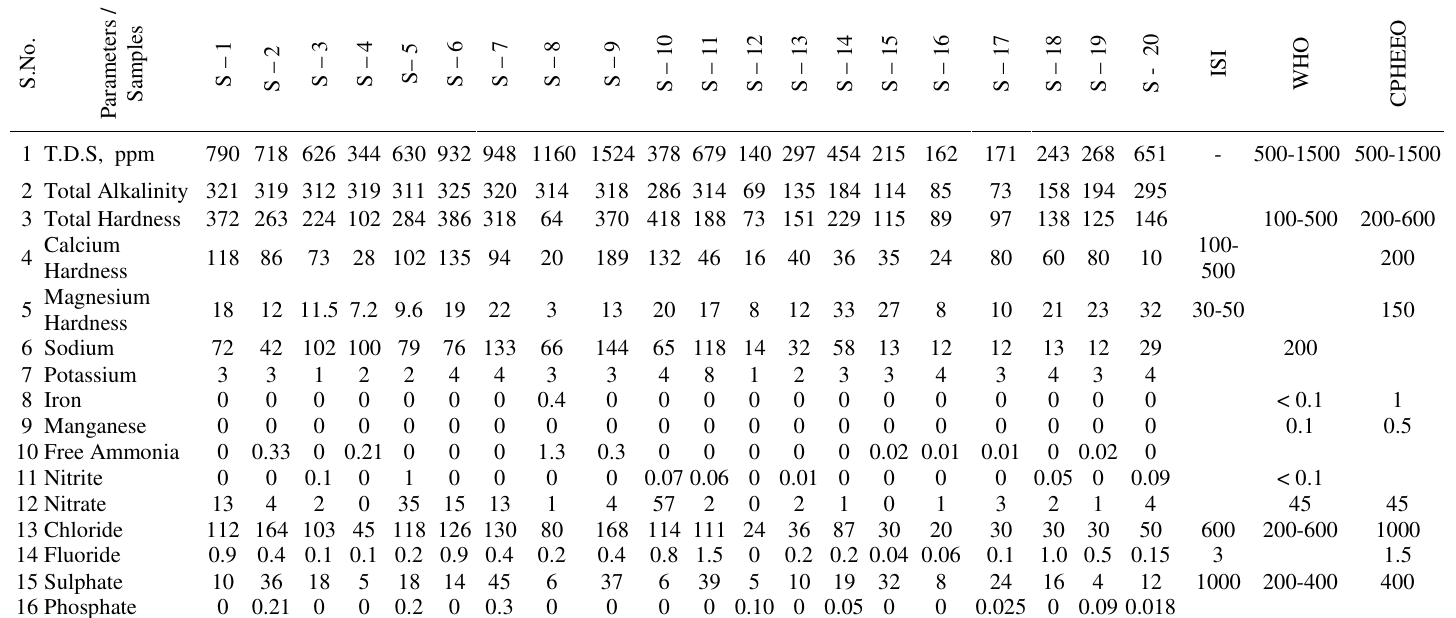
Table 2. Chemical parameters of water samples (The values are expressed in the unit of ppm).